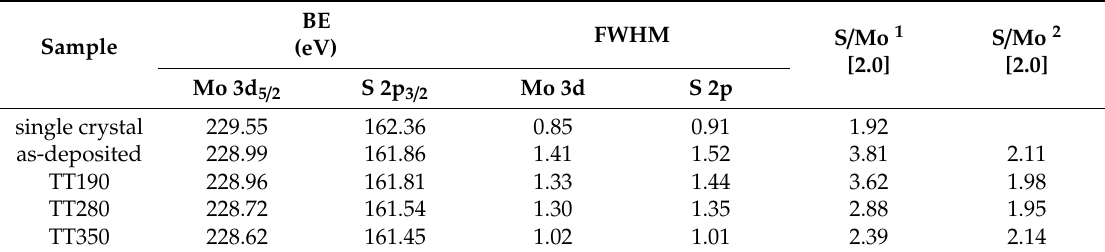
Table 1. Binding energy (BE), FWHM and S / Mo ratio of MoS 2 single crystal and IJD-MoS 2 deposited at 15 kV and annealed at di ff erent temperatures